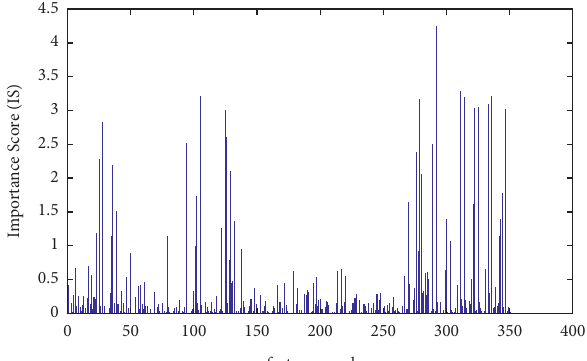
Figure 12: The importance scores of 352